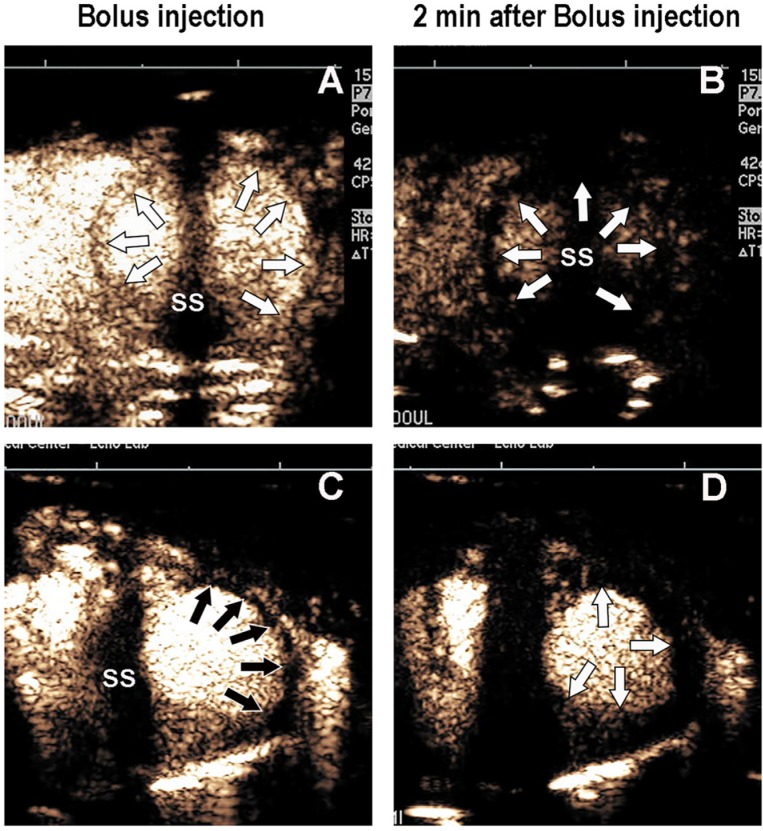
A bolus intravenous injection of Definity MB at 0.5 MI in a rat without infarction immediately following injection (Panel A) and at two minutes following injection (Panel B), where myocardial contrast is no longer present when using a triggered end systolic frame rate. In a rat with LAD infarction, the bolus microbubble injection demonstrated an anterior/anterolateral segment contrast defect (Panel C) immediately following injection but no myocardial contrast in normal or abnormal segments at two minutes (Panel D). SS = sternal shadow. White arrows = normal myocardium. Black arrows = contrast defects.